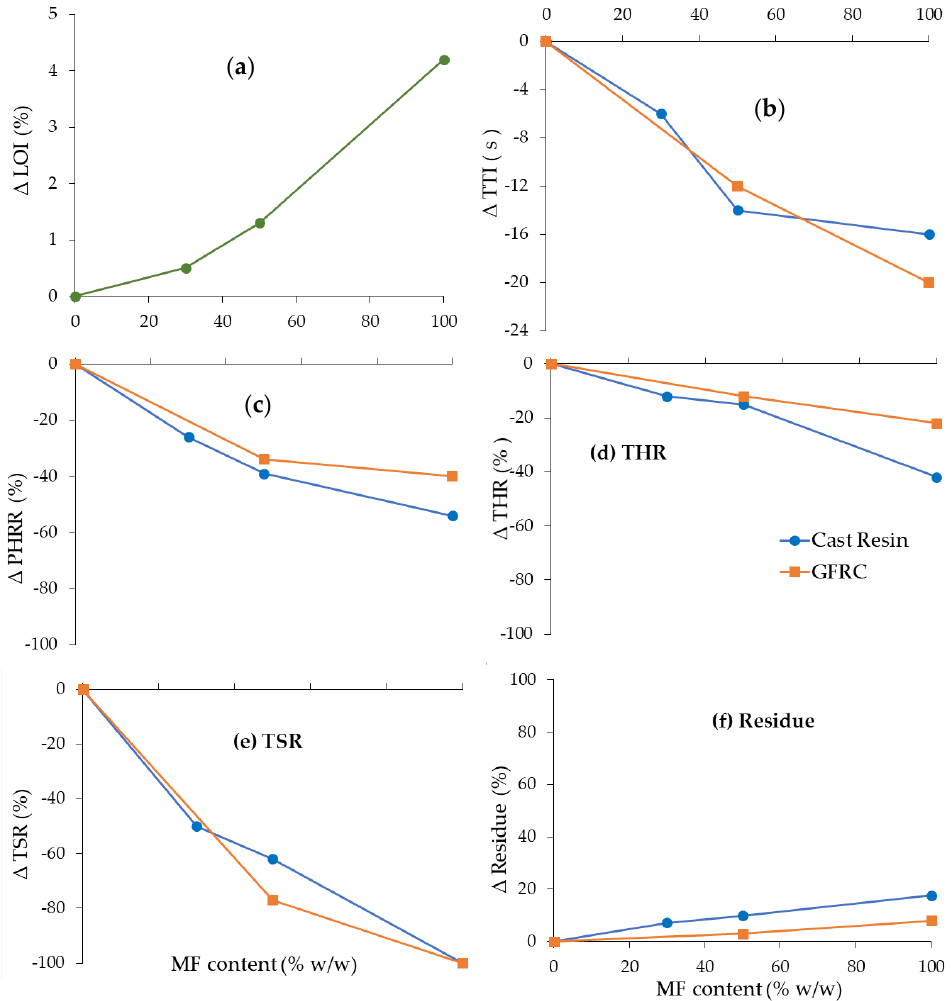
Figure 7. Effect of MF content on percent change in ( a ) LOI and ( b – f ) cone calorimetric parameters with respect to the respective values for UP in UP/MF cast resins and GFRC composites. The cured cast resin samples of UP, MF, and their blends were also subjected to cone calorimetric tests at 50 kW/m 2 heat flux and their heat release rates (HRR), rates of smoke release (RSR), and percentage mass losses recorded. The HRR, % mass loss and RSR versus time curves for UP, MF, and their blends are shown in Figure S3, and the derived parameters are listed in Table 6.